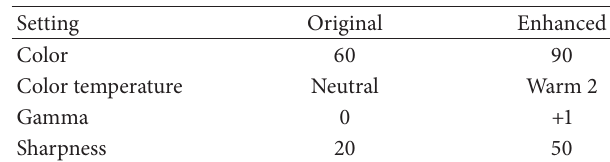
Table 2: Settings for the original and enhanced